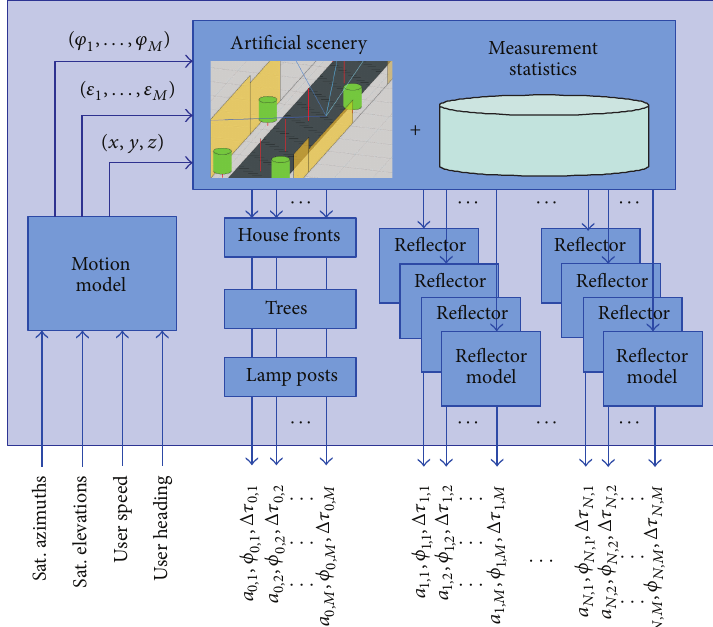
Figure 15: Block diagram of the WMS channel model.